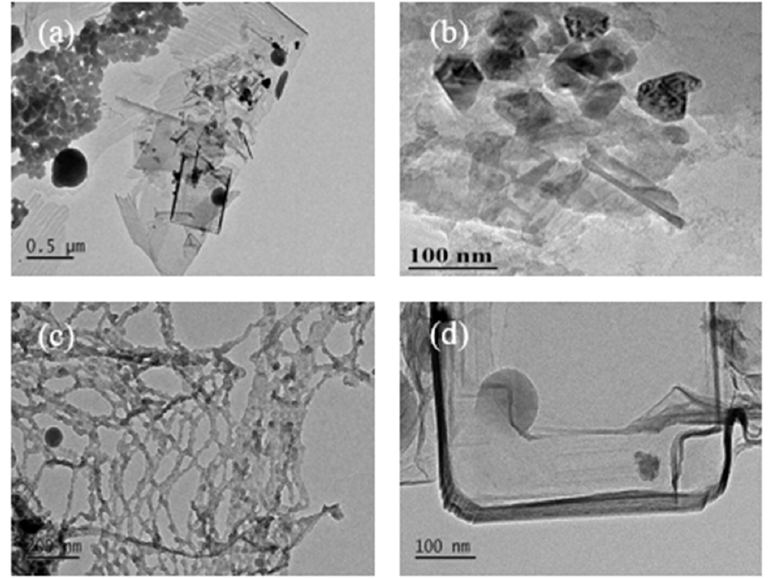
Figure 4. TEM images of carbon nanostructures at 600 °C: ( a ) 1CMC concentration carbon nanostructures; ( b ) 2CMC concentration carbon nanostructures; ( c ) 5CMC concentration carbon nanostructures; ( d ) 10CMC concentration carbon nanostructures.